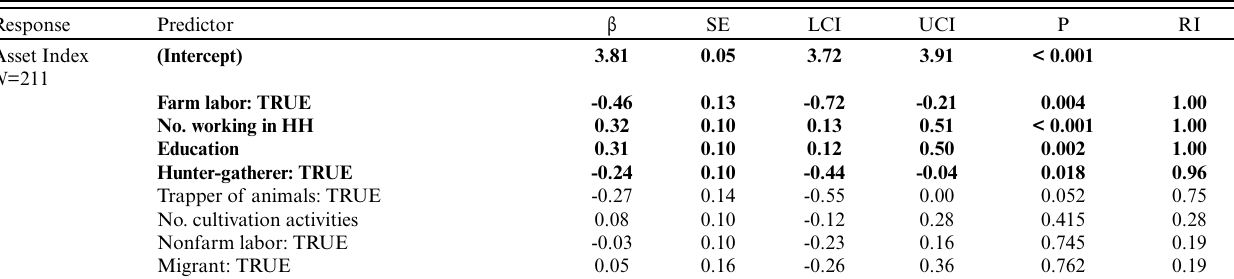
Table 1 . Summary of averaged linear model (LM) fitted with normal errors to investigate predictors associated with household (HH) wealth in systematically sampled villages, in the Moramanga district of